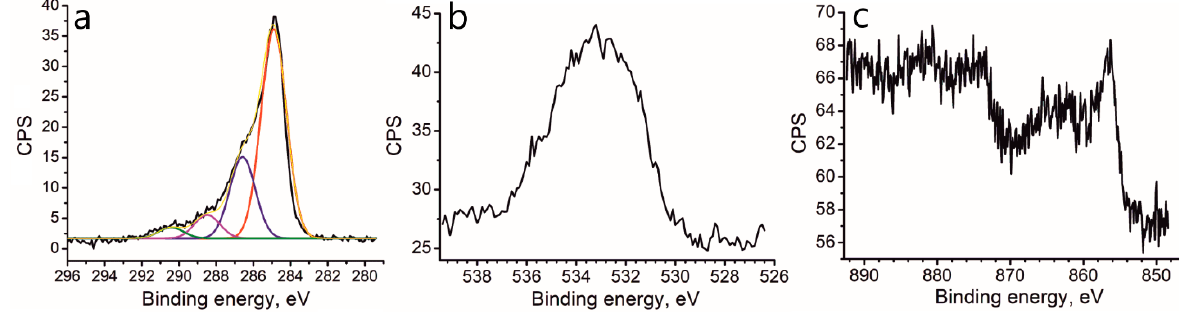
Figure 5. Elemental XPS spectra for the r OMC/Ni sample: ( a ) C1s XPS spectrum; ( b ) O1s XPS spectrum; ( c ) Ni2p XPS spectrum.